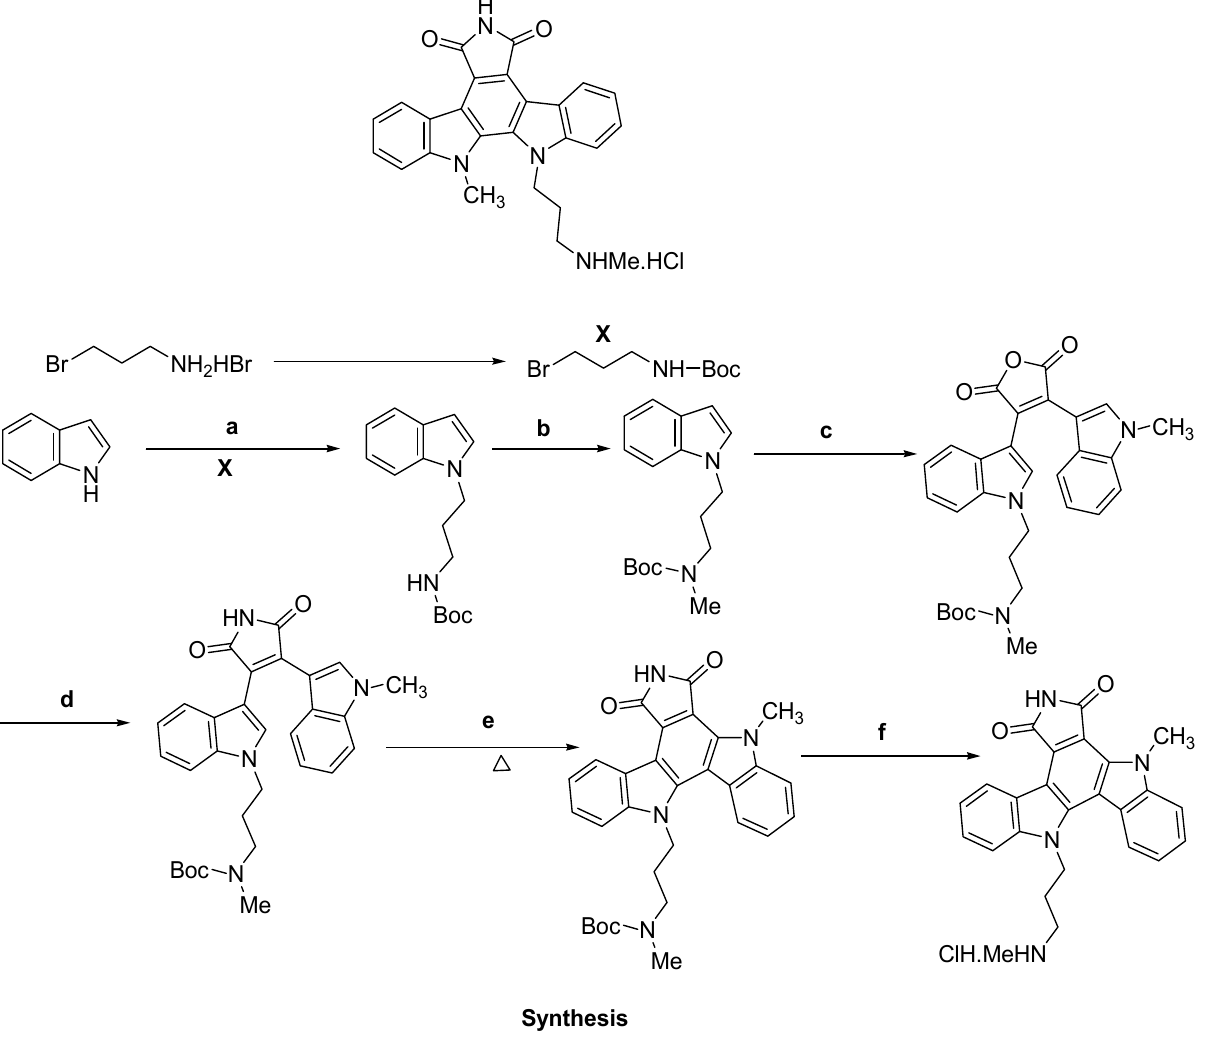
Figure 22. Bioactive indolocarbazole